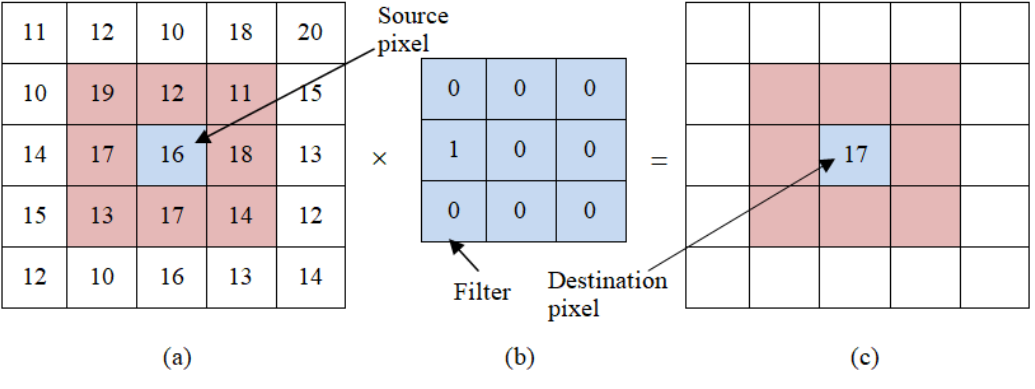
Figure 3. Convolution operation of the CNN.